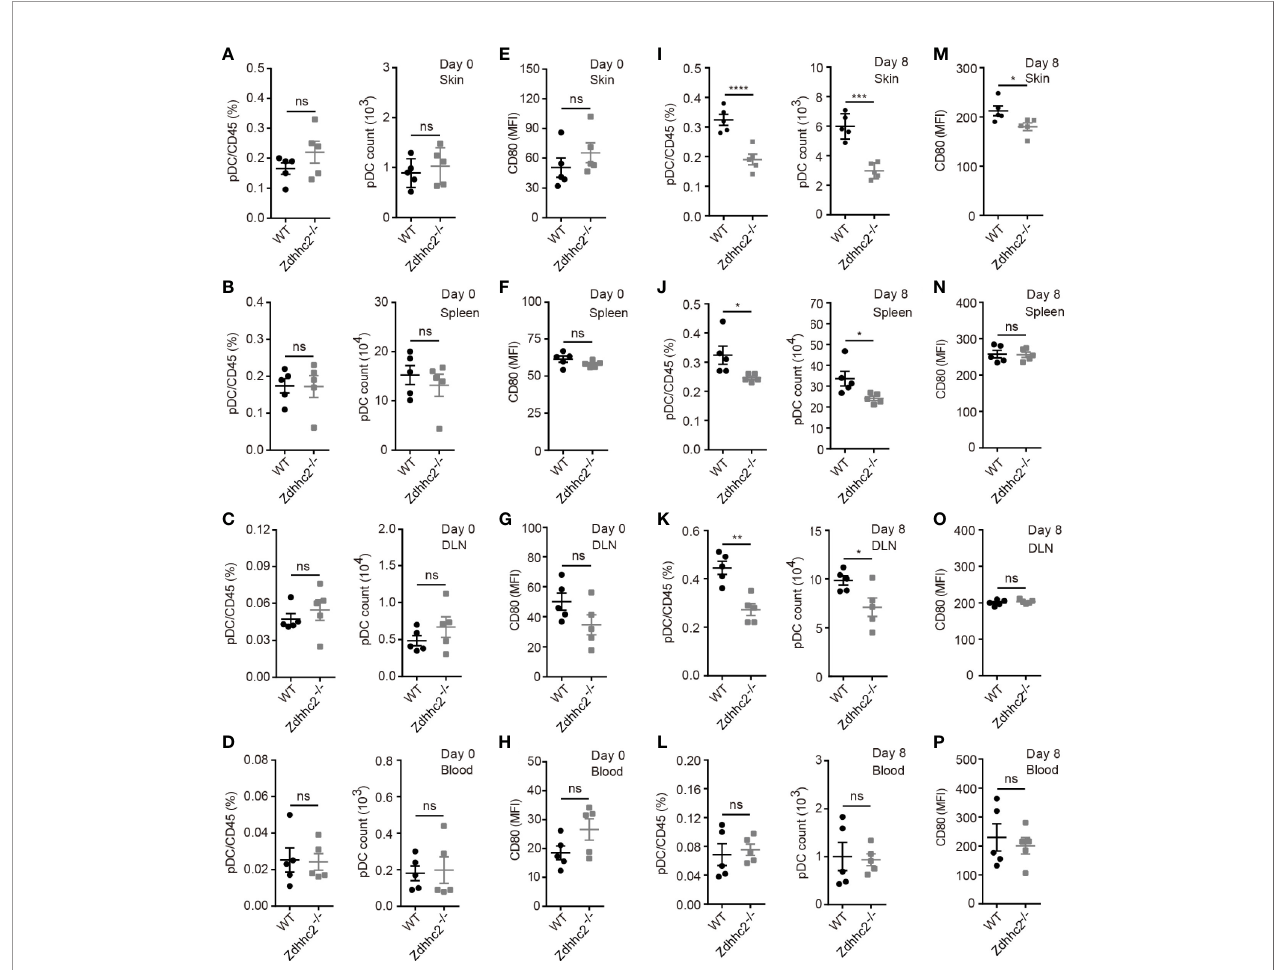
FIGURE 3 | The pDC analysis in four types of organs of WT and Zdhhc2 − / − mice following imiquimod treatment for 0 and 8 days. (A, I) Comparison of the pDC frequencies in WBC and pDC absolute number in the lesioned skin of WT and Zdhhc2 − / − mice after 0 and 8 days imiquimod stimulation. (E, M) Mean fl uorescence intensity (MFI) of CD80 for pDC in the lesioned skin of WT and Zdhhc2 − / − mice after 0 and 8 days imiquimod stimulation. (B, J) Comparison of the pDC frequencies in WBC and pDC absolute number in the spleen of WT and Zdhhc2 − / − mice after 0 and 8 days imiquimod stimulation. (F, N) MFI of CD80 for pDC in the spleen of WT and Zdhhc2 − / − mice after 0 and 8 days imiquimod stimulation. (C, K) Comparison of the pDC frequencies in WBC and pDC absolute number in the DLN of WT and Zdhhc2 − / − mice after 0 and 8 days imiquimod stimulation. (G, O) MFI of CD80 for pDC in the DLN of WT and Zdhhc2 − / − mice after 0 and 8 days imiquimod stimulation. (D, L) Comparison of the pDC frequencies in WBC and pDC absolute number in the blood of WT and Zdhhc2 − / − mice after 0 and 8 days imiquimod stimulation. (H, P) MFI of CD80 for pDC in the blood of WT and Zdhhc2 − / − mice after 0 and 8 days imiquimod stimulation (mean ± SEM). Experiments were involving fi ve mice for each time point per genotype (mean ± SEM). * p < 0.05, ** p < 0.01, *** p < 0.001, **** p < 0.0001, unpaired Student ’ s t- test. ns, not signi fi